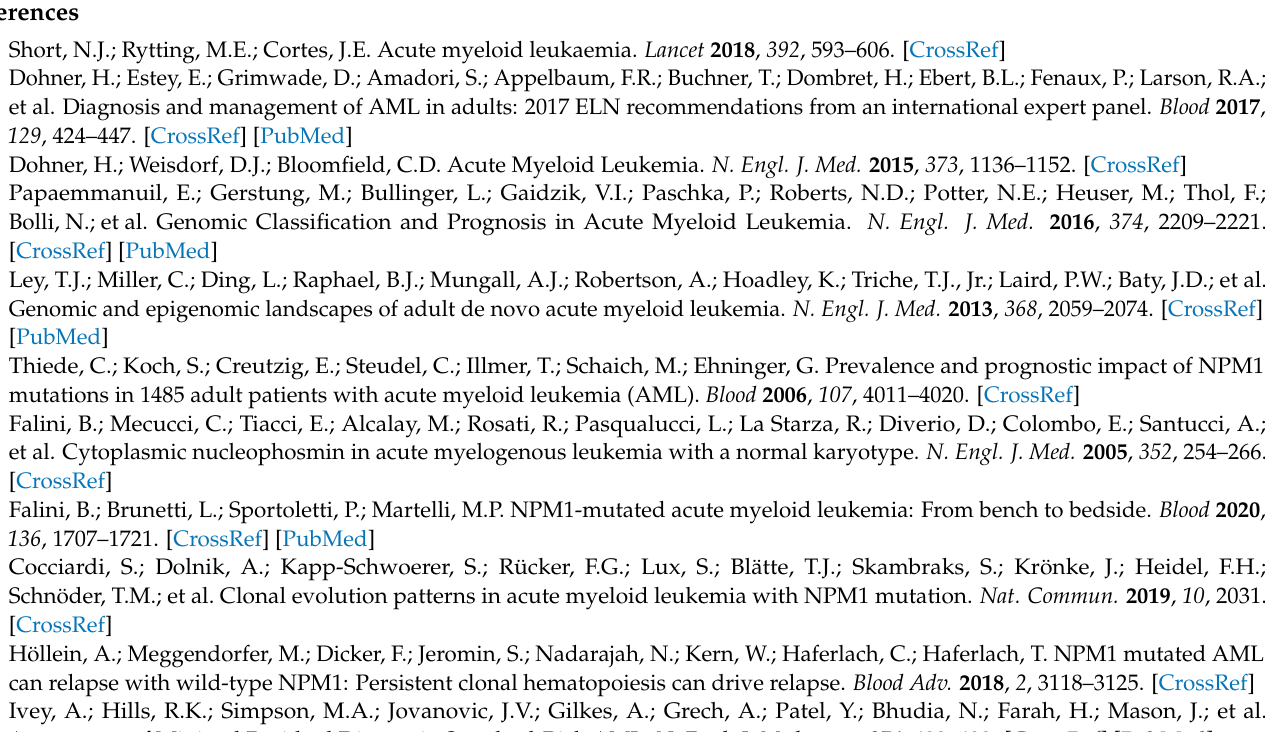
AMLs, Figure S5: Tetramer staining of TCR-transduced T-cells as used for mouse experiments, Figure S6: FACS analyses of mouse bone marrow